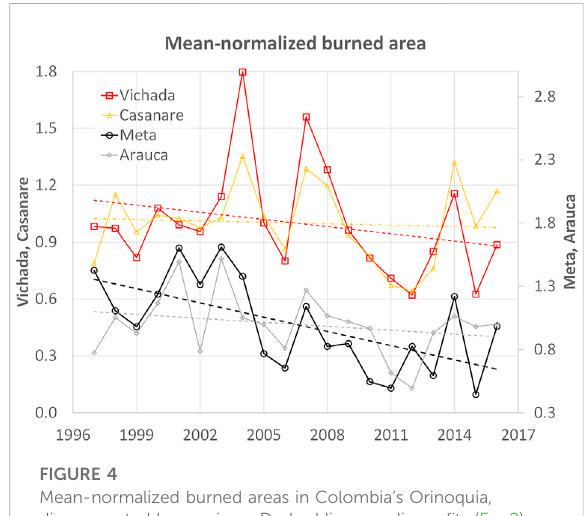
FIGURE 4 Mean-normalized burned areas in Colombia ’ s Orinoquia, disaggregated by province. Dashed lines are linear fi ts (Eq.